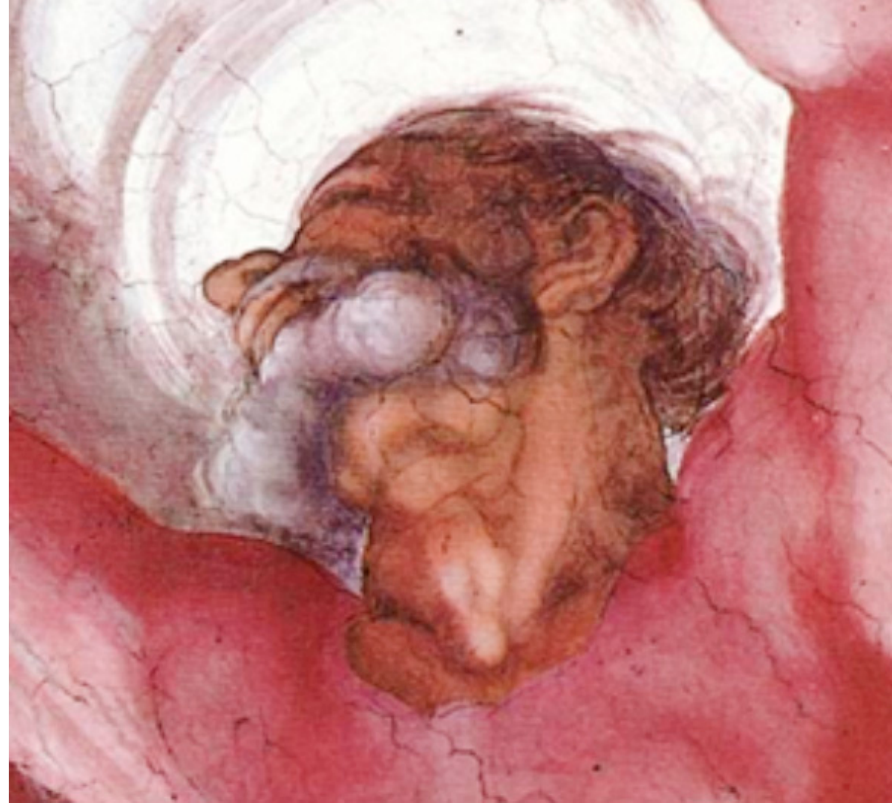
Figure 7. The ventral view of God’s brain after Michelangelo in the Sistine Chapel. A close-up view of a section.